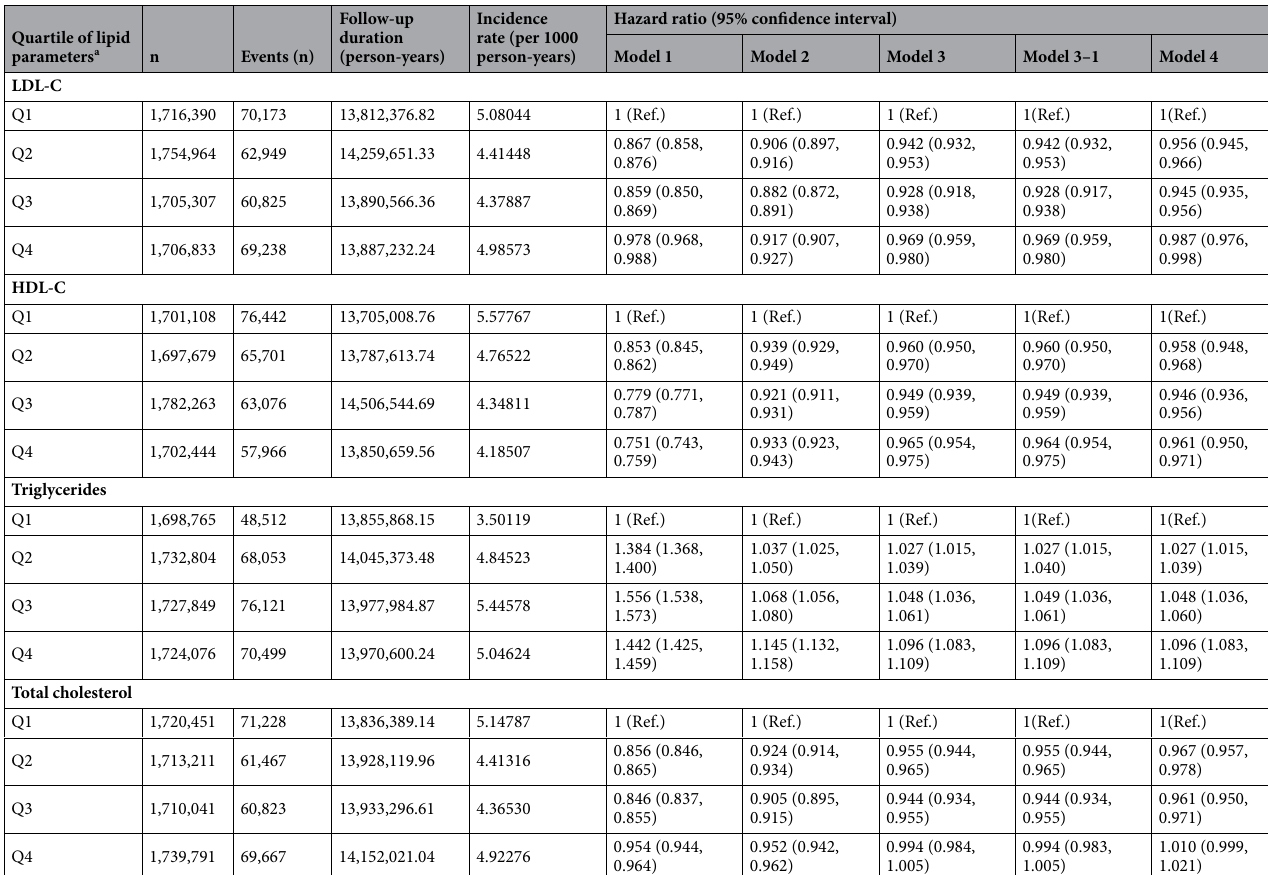
Table 2. Hazard ratios for the incidence of all-cause dementia according to quartile of lipid parameters. Model 1: unadjusted. Model 2: adjusted for age and sex. Model 3: model 2 plus body mass index, diabetes, hypertension, current smoking status, alcohol consumption status, regular exercise, and estimated glomerular filtration rate. Model 3–1: model 3 plus monthly household income, and Charlson Comorbidity Index. Model 4: model 3 plus statin use. LDL-C low-density lipoprotein cholesterol, HDL-C high-density lipoprotein cholesterol. a LDL-C quartile ranges: Q1 (LDL-C < 94 mg/dl), Q2 (94 mg/dl ≤ LDL-C < 116 mg/dl), Q3 (116